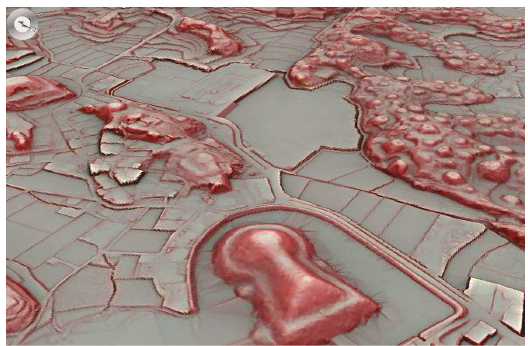
Fig16. Animation by Land-Viewer (RRIM of Lidar)